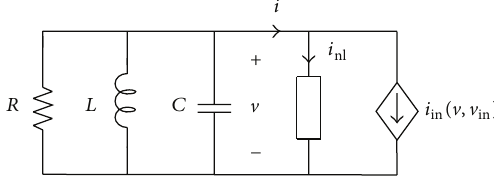
Figure 2: Equivalent model of the ILFD in Figure 1.